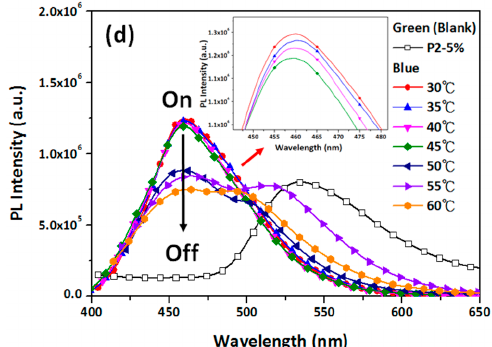
Figure 9. ( a ) Photoluminescence (PL) spectra of P1 and P2 nanofibers blended with 10 wt % BNPTU. ( b ) Comparison of P2-5% nanofibers with different Hg 2+ concentrations between 10 − 2 , 10 − 3 and 10 − 4 M in aqueous solution. ( c ) Relative fluorescence intensity changes ( I 450 / I 530 ) of P2-5% ES nanofibers in aqueous solutions with various Hg 2+ concentrations. ( d ) PL spectra of P2-5% ES nanofibers in 10 − 2 M Hg 2+ solution with a temperature increase from 30 to 60 °C.